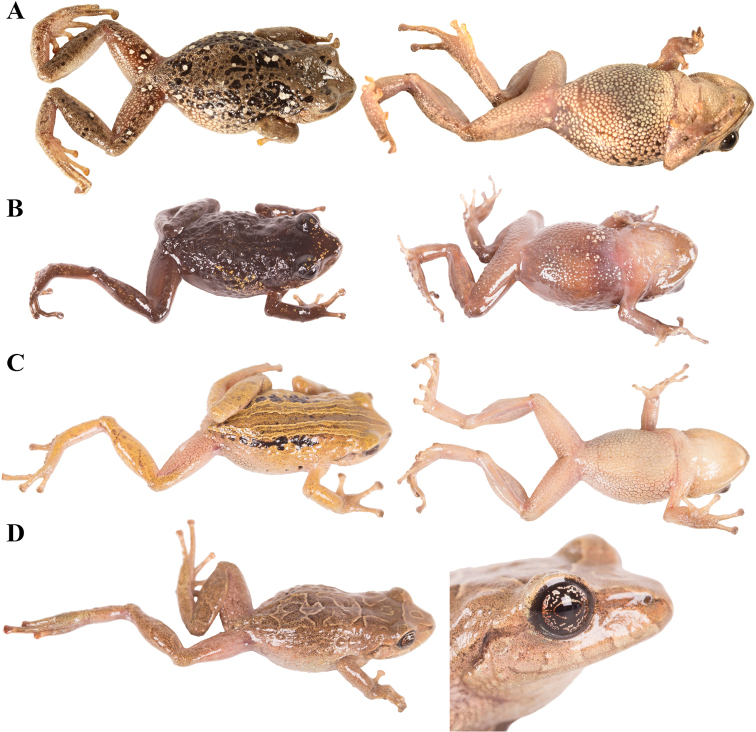
Color variation in live individuals of Pristimantis
gloria sp. nov. AQCAZ 57201 (holotype, female, SVL 35.8 mm) BQCAZ 62778 (male, SVL 19.7 mm) CQCAZ 62780 (juvenile female, SVL 23.5 mm) DQCAZ 62789 (juvenile female, SVL 21.8 mm) For A–C dorsolateral view on the left, ventral view on the right. For D dorsolateral view on the left, close up of the eye in the right.